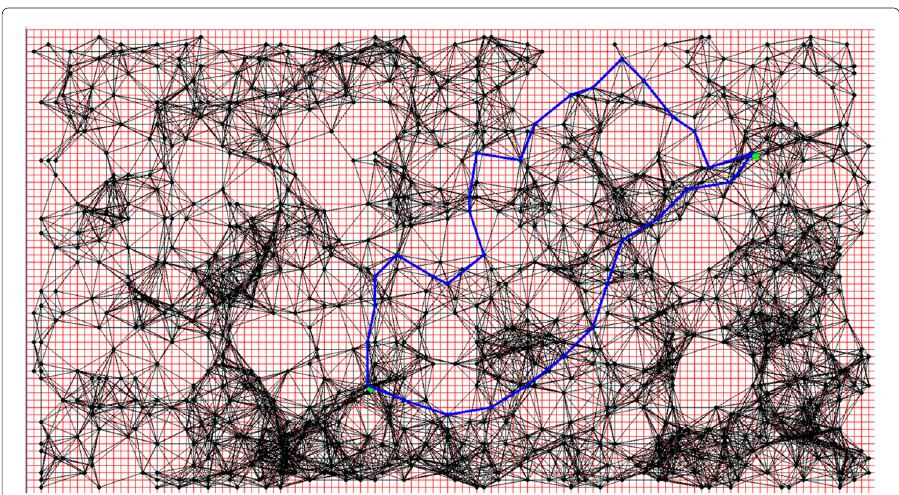
Fig. 1 Output From a Simulation. The city grid is represented by red lines. Black lines show that two nodes are within transmission radius. Source and destination nodes are shown in green, and two chosen paths are shown in